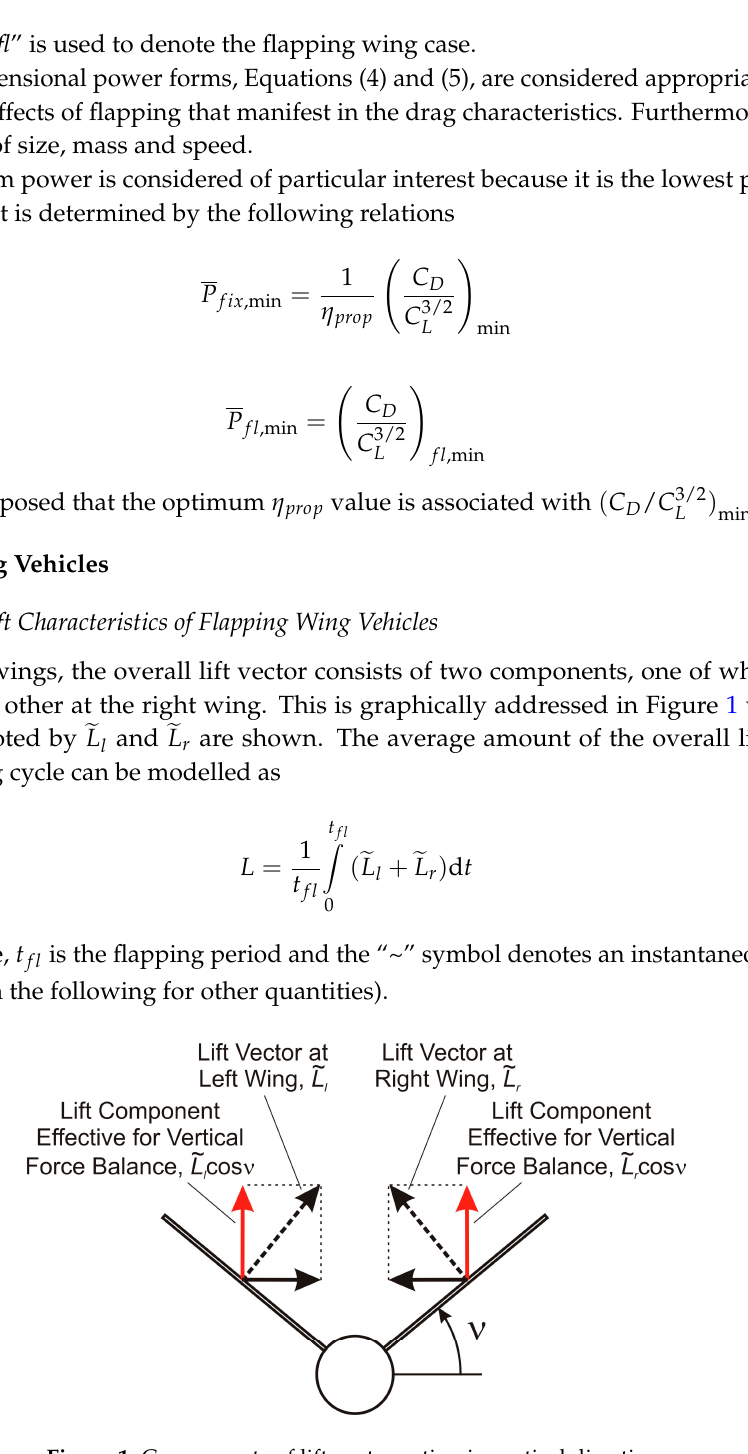
Figure 1. Components of lift vector acting in vertical direction.